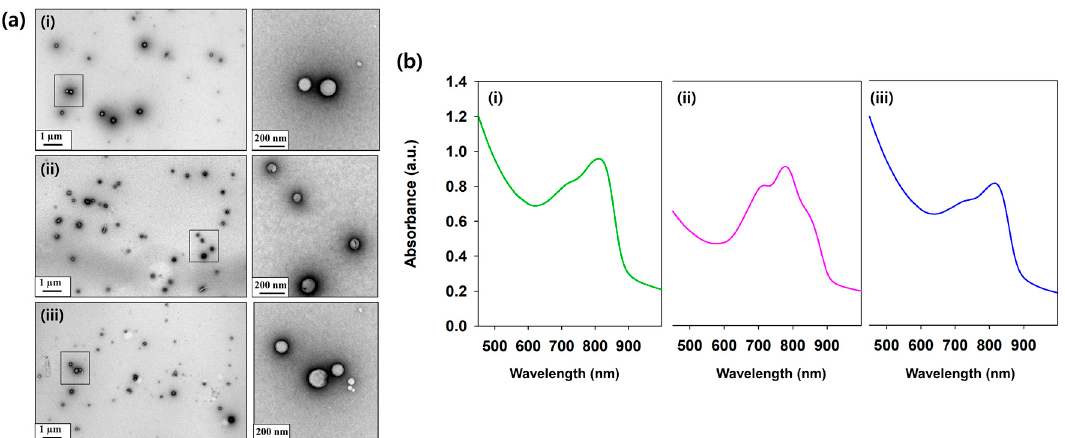
Figure 3. ( a ) Transmission electron microscopy (TEM) images of the nanohydrogels (right image; the enlarged rectangle region on the left images) and ( b ) their absorption spectra. i: Nanohydrogel (A); ii: Nanohydrogel (B); iii: Nanohydrogel (C).